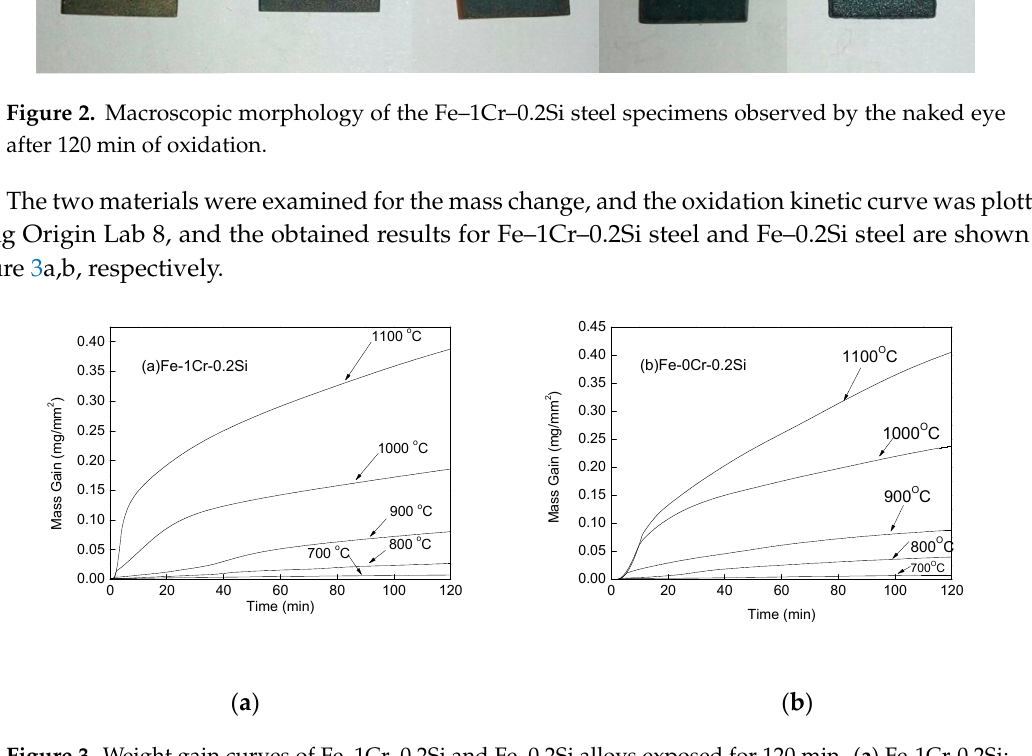
Figure 3. Weight gain curves of Fe–1Cr–0.2Si and Fe–0.2Si alloys exposed for 120 min. ( a ) Fe-1Cr-0.2Si; ( b ) Fe-0Cr-0.2Si.